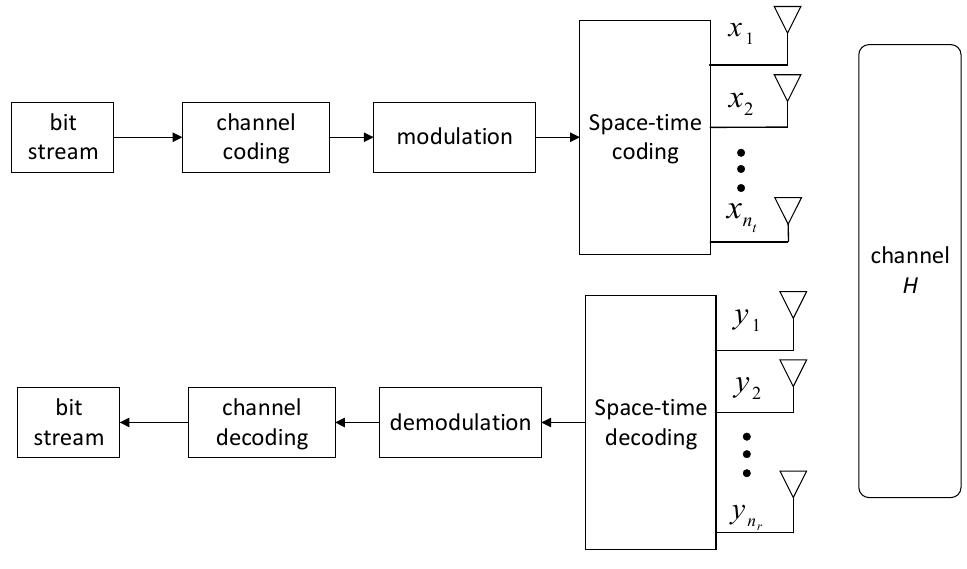
Figure 1. Schematic diagram of the MIMO system.